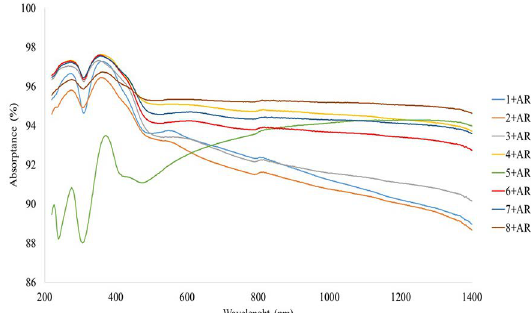
Figure 2. Percentage of absorptance of the black chromium films coated by the AR layer.